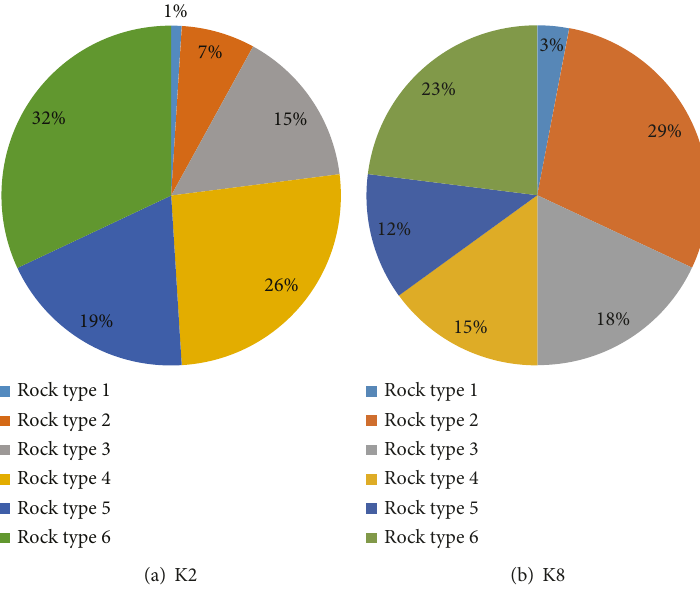
Figure 6: The thickness proportion of different rock types of wells K2 and